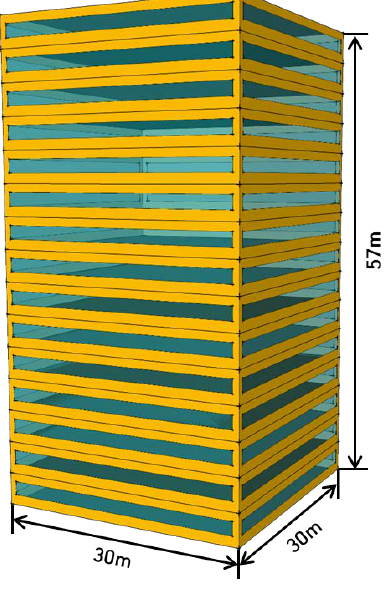
Figure 13. Model of office building.